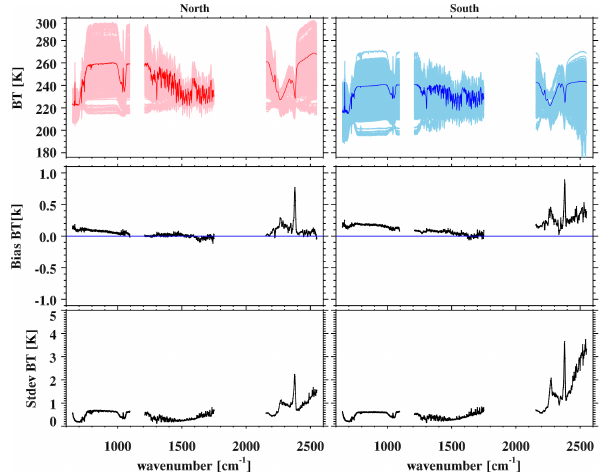
Figure 10. Same as Fig. 9 but for